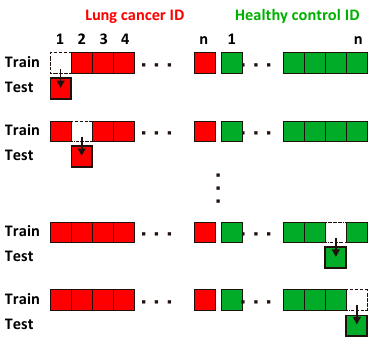
Figure 5. Schematic illustrating the leave-one-out cross-validation (LOOCV) procedure. A data point is repeatedly exchanged to categorize the training and testing data set.